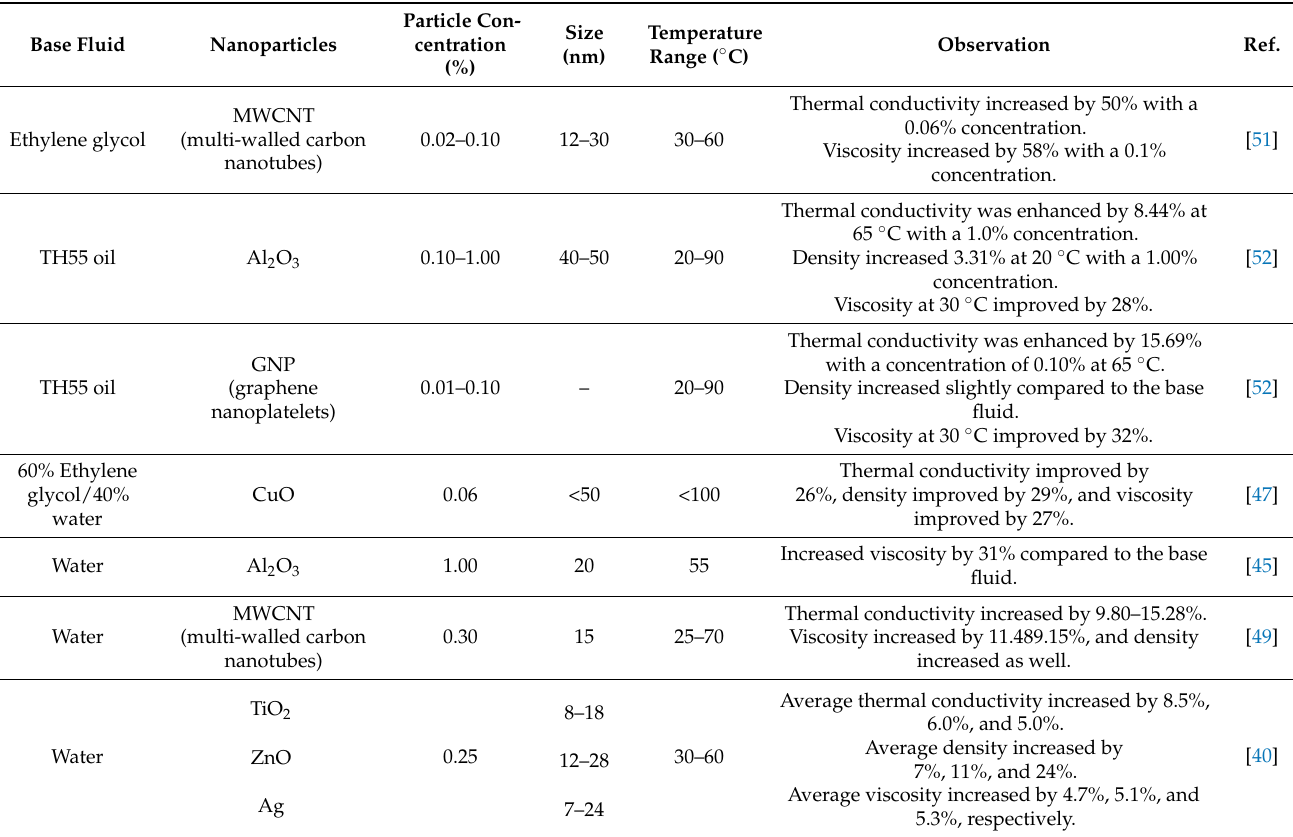
Table 3. Influences of the concentration of nanoparticles on nanofluid properties according to different